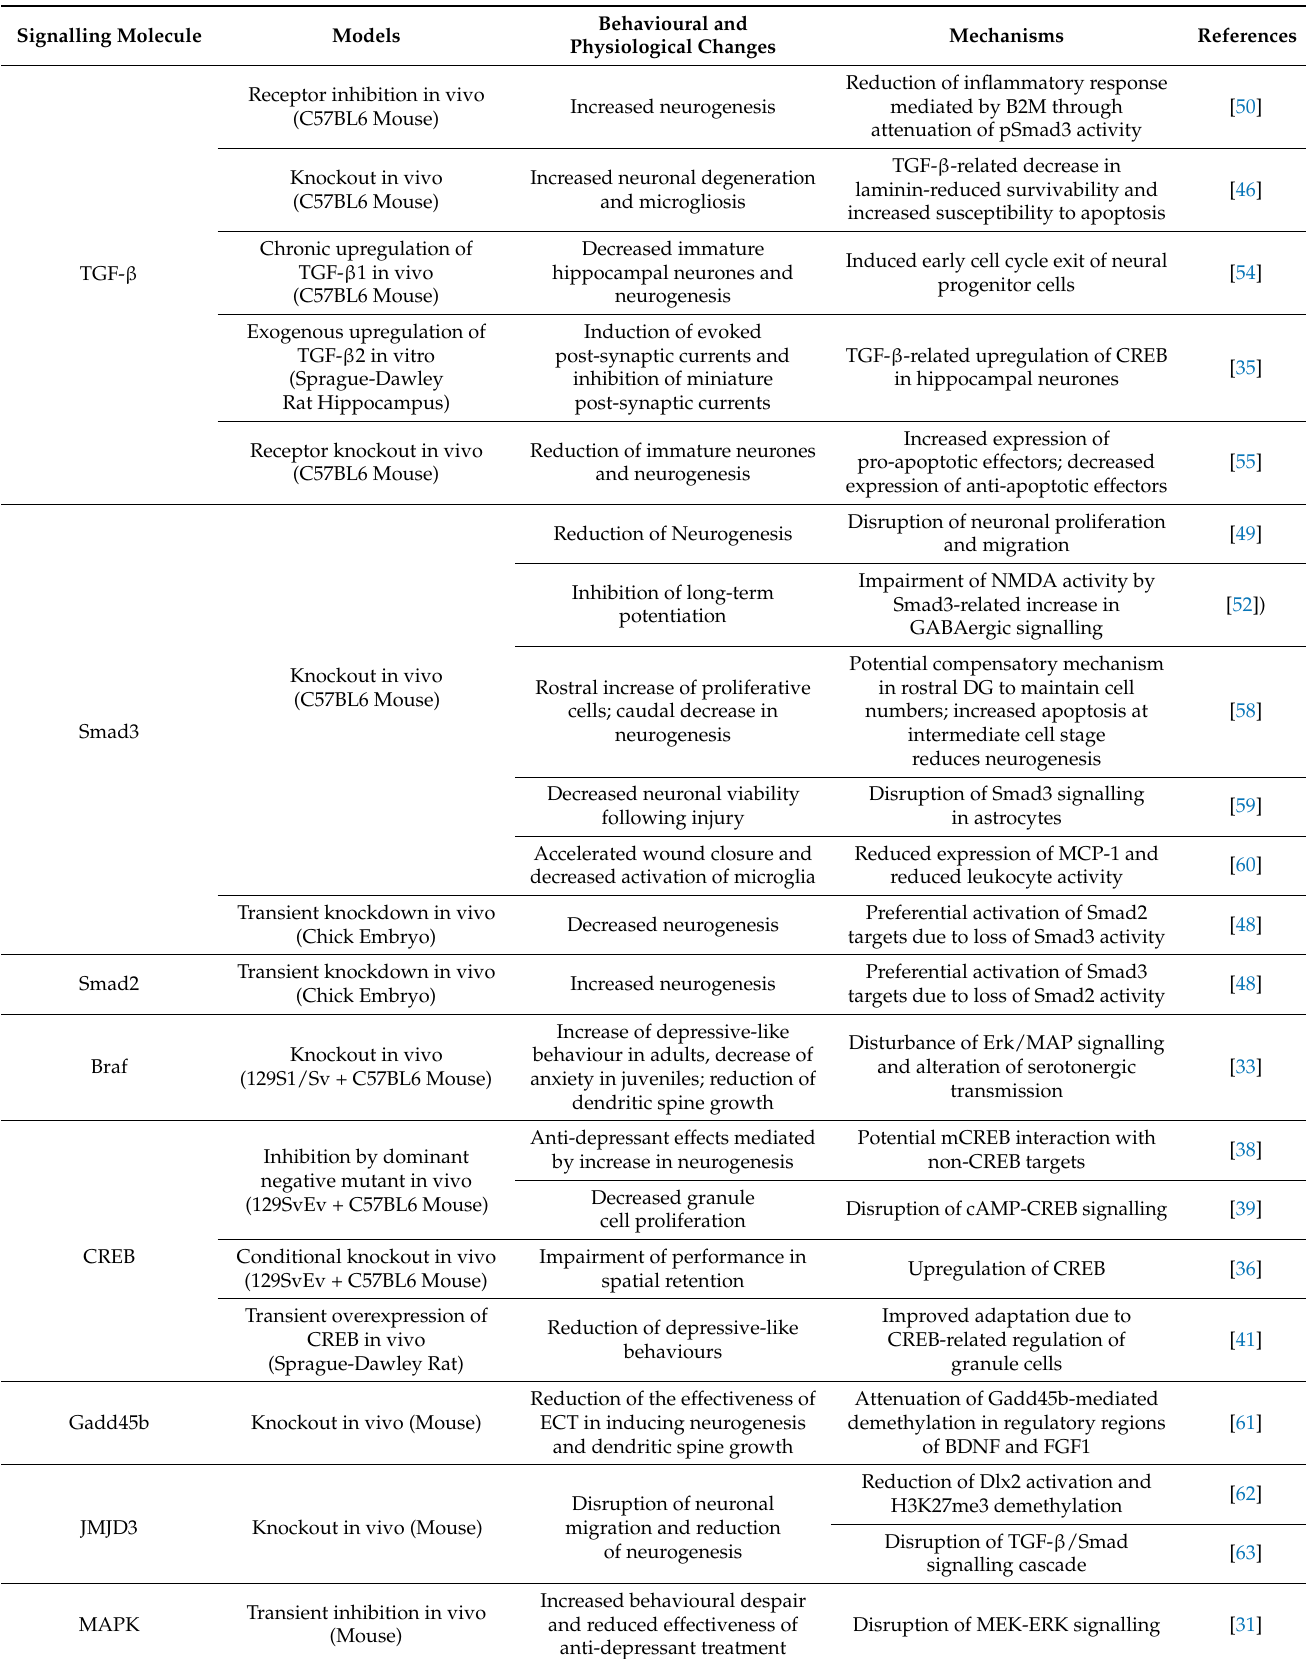
Table 1. TGF- β canonical and non-canonical signalling mechanisms in behavioural and physiological changes. Signalling